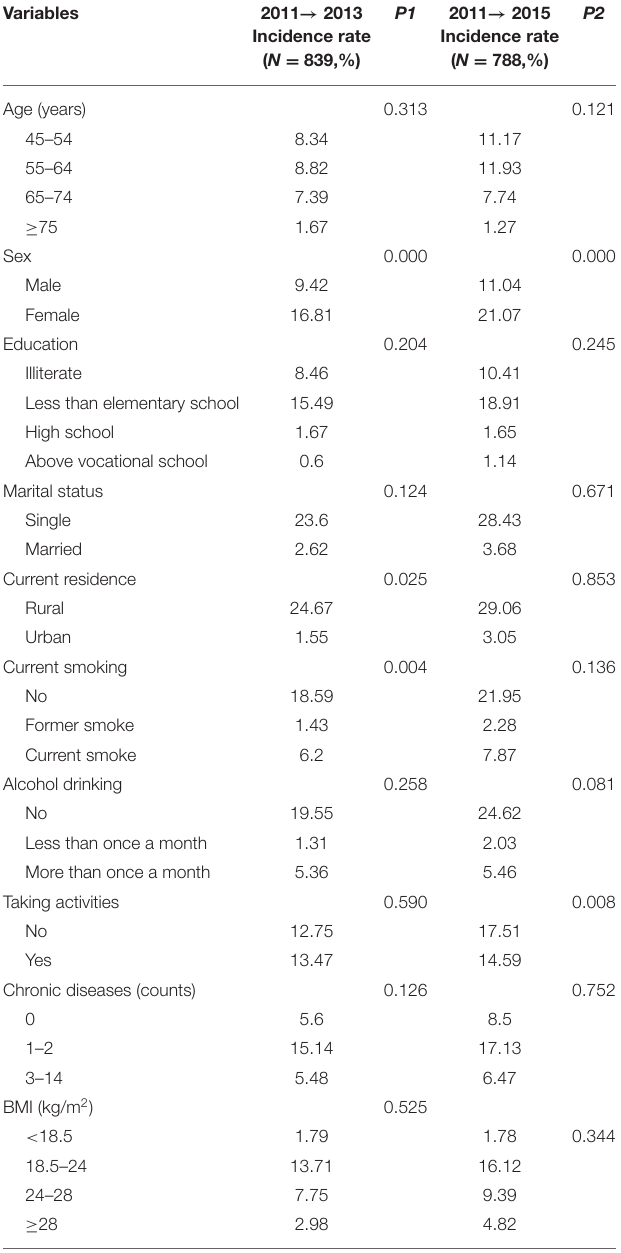
TABLE 3 | Baseline characteristics classified according to subsequent onset of depressive symptoms.